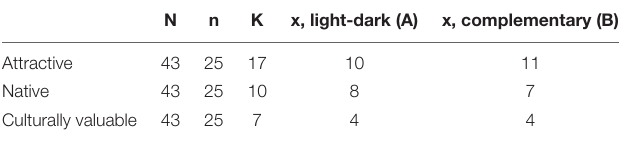
TABLE 1 | Parameters used in the analyses with the hypergeometric